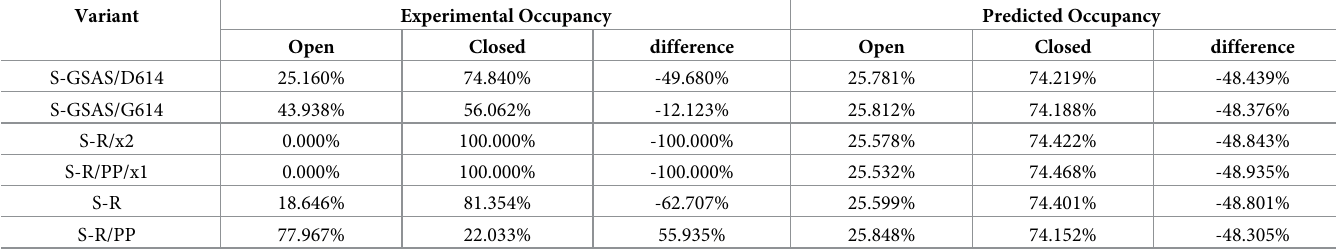
Table 2. Experimental and predicted occupancies for the open and closed states and their difference for multiple SARS-CoV-2 variants. Experimental values obtained from Gobeil et al . [30] and Xiong et al . [34]. Variant Experimental Occupancy Predicted Occupancy Open Closed difference Open